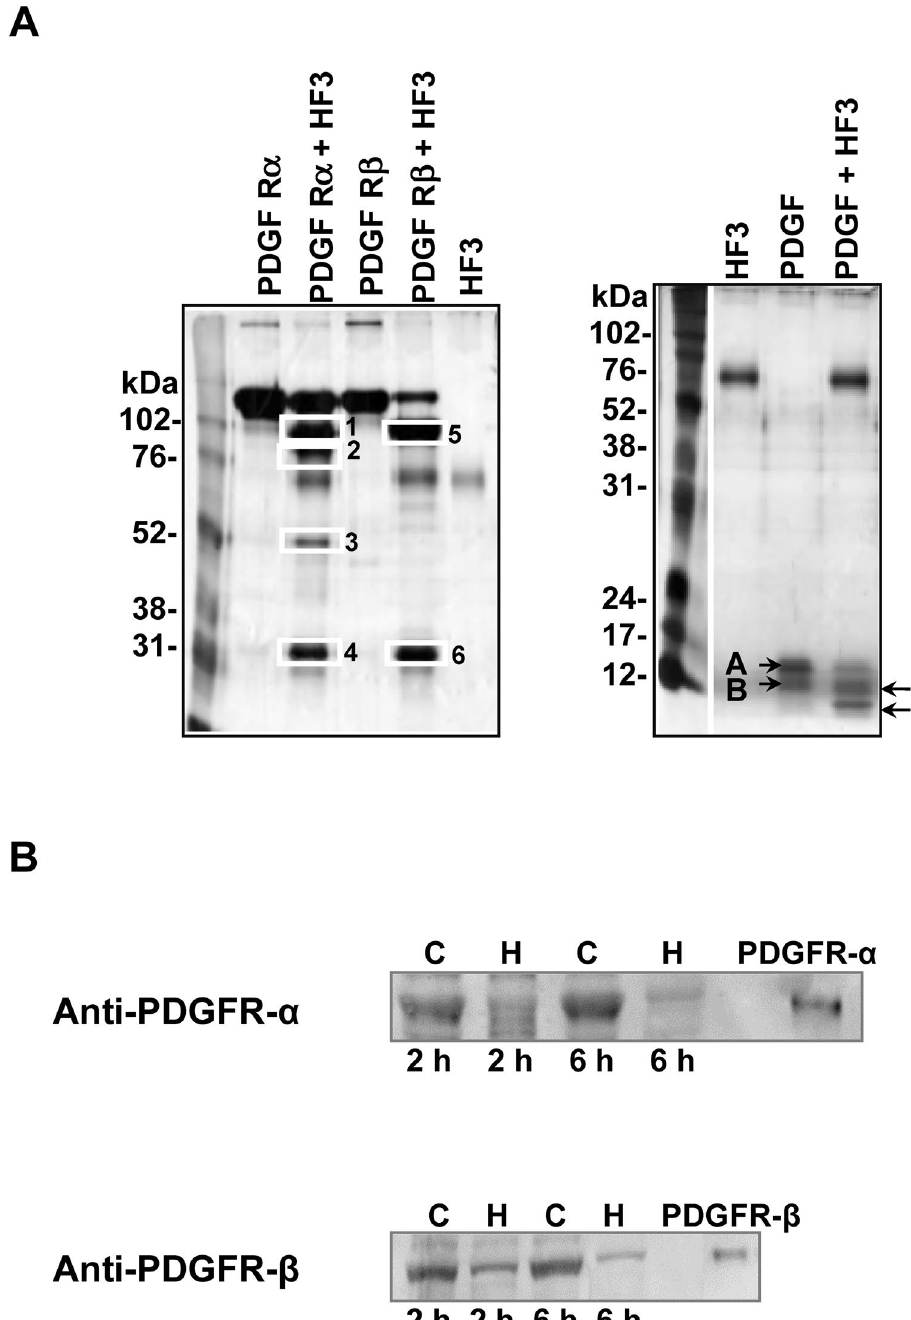
Figure 7. Activity of HF3 upon PDGFR and PDGF. ( A ) HF3 cleaves PDGFR (alpha and beta forms) and PDGF in vitro. PDGFR-α (recombinant mouse PDGFR-α-Fc chimera), PDGFR-β (recombinant mouse PDGFR- β-Fc chimera) and PDGF were incubated with HF3, as described in “Materials and methods”, and submitted SDS-PAGE. White rectangles indicate proteins bands identified by mass spectrometry. Letters A and B indicate the subunits of the disulfide linked PDGF heterodimer. Arrows indicate cleavage products generated by HF3. Proteins were stained with silver. ( B ) Degradation of PDGFR-α and PDGFR-β in the mouse skin injected with HF3, as shown by Western blot analysis. Protein samples (30 μg) from control skin (C) or skin injected with HF3 (H), and PDGFR-α (recombinant mouse PDGFR-α-Fc chimera) and PDGFR-β (recombinant mouse PDGFR-β-Fc chimera) (10 ng) were immunostained with anti-PDGFR-α and anti-PDGFR-β antibodies. Full- length images of Western blots and SDS-PAGE profiles of mouse proteins from control and hemorrhagic skins in comparison with PDGFRα and PDGFRβ are shown in Supplementary Figure